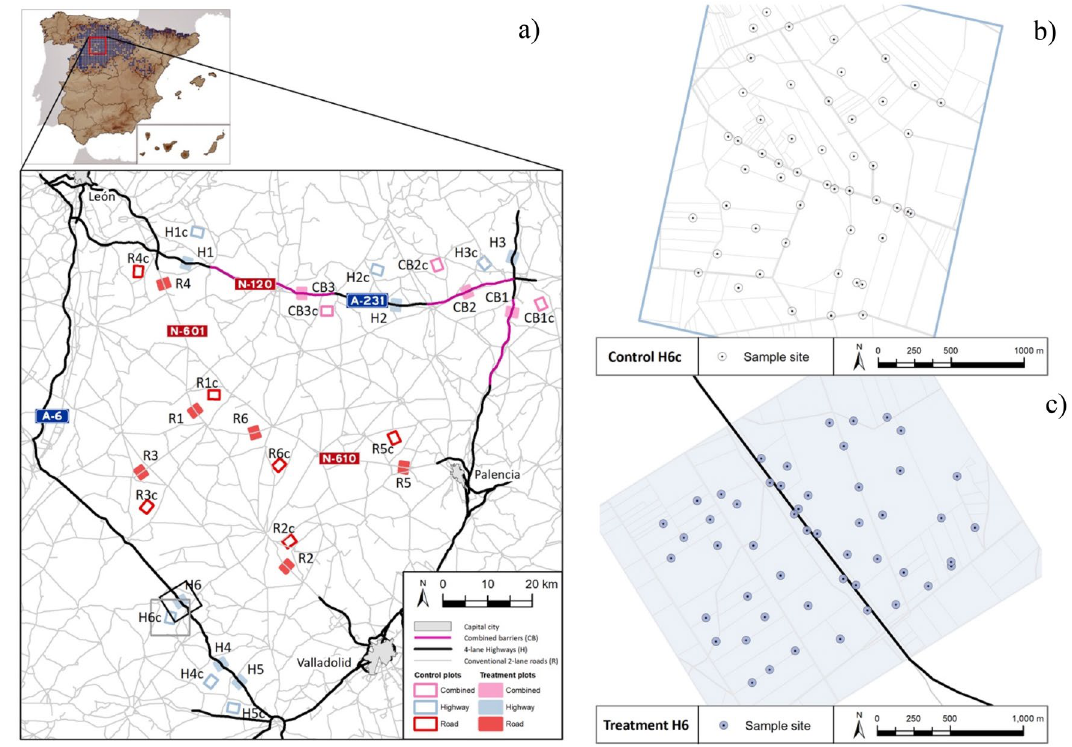
Figure 1. ( a ) Map of study area and sampling locations (plots). Plots are colored according to the features of the potential barrier type by which they are intersected; conventional 2-lane roads (R, Red), 4-lane highways (H, Blue), and combined barriers (CB, Purple), unpaved rural tracks (T, unfilled). Inset shows known distribution of common vole in Spain (10 × 10 km UTM-grids; 126 ) where the red square delimits the study area. Plot codes correspond to Table A.1. Examples of trapping stations (10 traps per point) across control ( b ) and treatment ( c ) plots are shown for illustration purposes. Maps were generated using ESRI ArcGIS 10.3 Desktop platform (https:// www. esri. com/ en- us/ home) 58 .